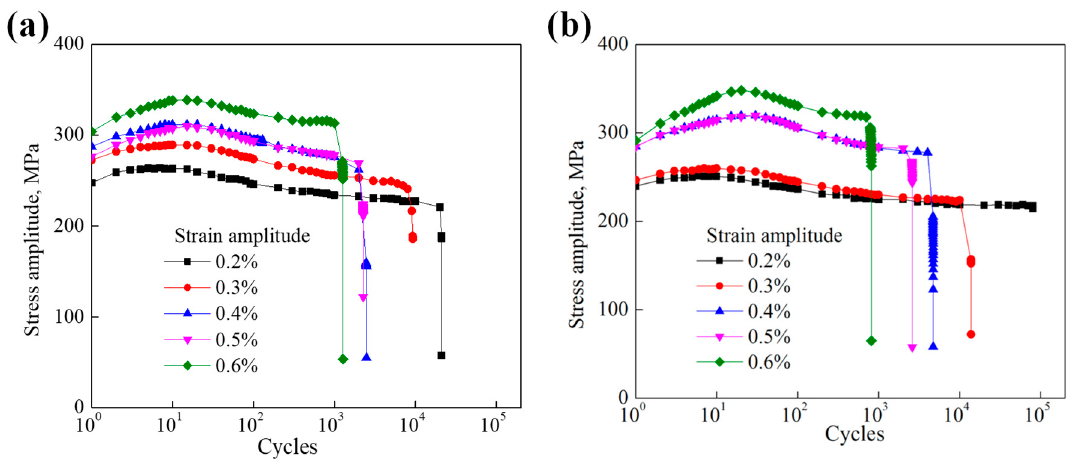
Figure 2. Cyclic stress response curves of the CDSS. ( a ) Unaged, ( b ) Thermal aged at 400 °C for 10,000 h.